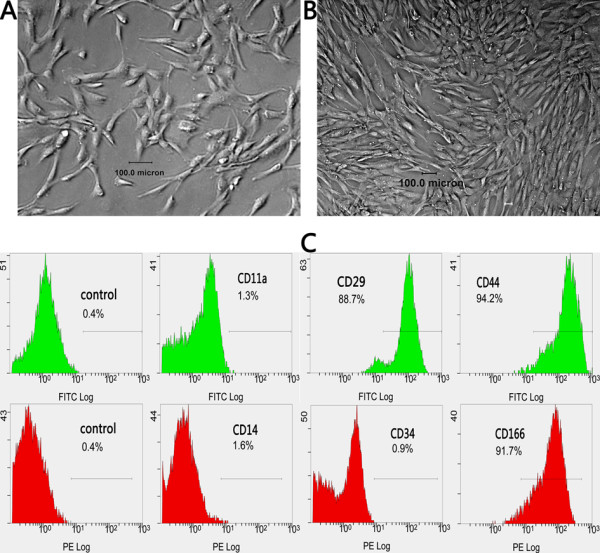
Isolation and identification of bone marrow mesenchymal stem cells of human first-trimester abortus. Adhered spindle cells appeared in culture of whole bone marrow (A) and they clonally grew and spread at the bottom of a culture dish within the 12th day (B). Flow cytometric analysis showed that passage 6 of the isolated cells strongly expressed the surface markers of mesenchymal stem cells, such as CD29, CD44 and CD166, but almost no markers of Hematopoietic Stem Cells, such as CD11a, CD14 and CD34 (C). FITC, fluorescein isothiocyanate; PE, phycoerythrin.